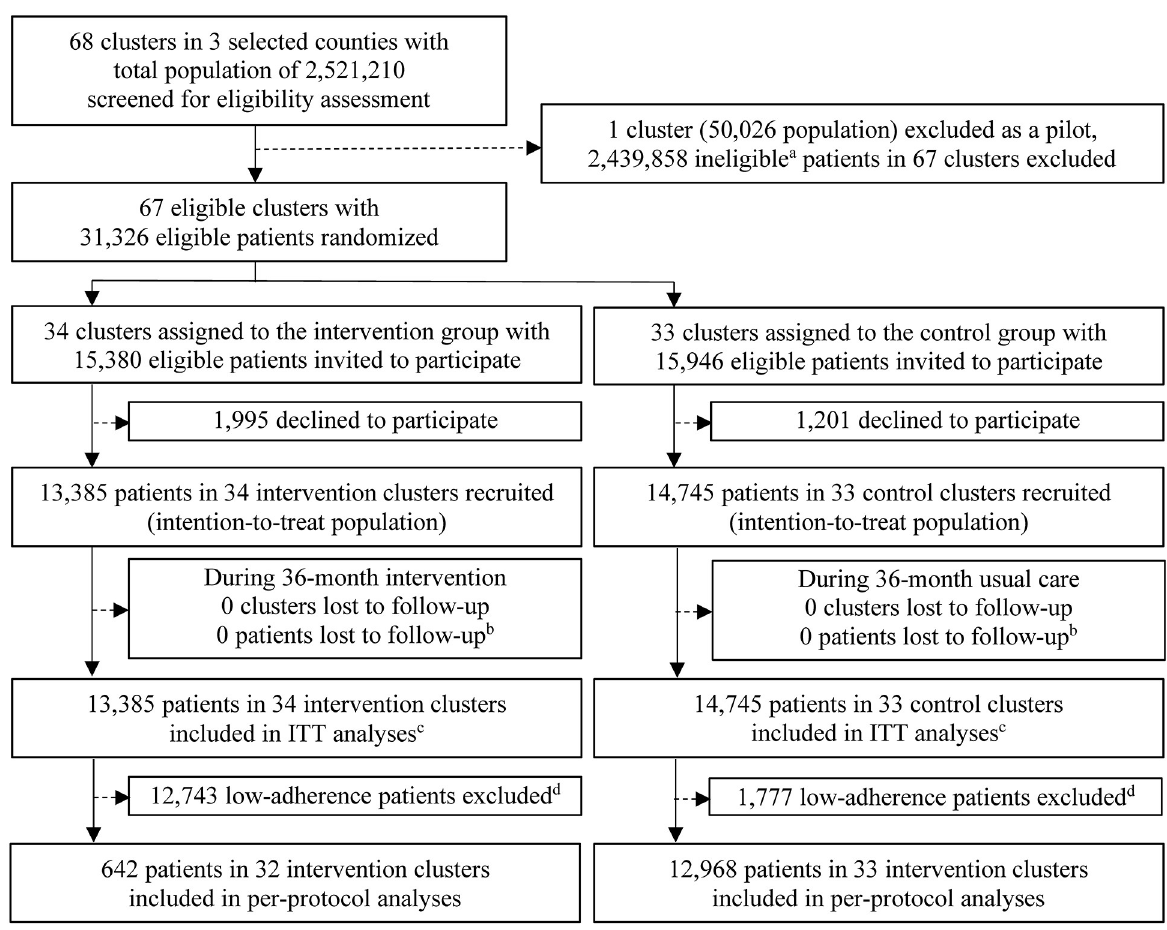
Fig 1. Trial profile. a Ineligible patients included 2,419,058 who didn’t meet the eligibility criteria (aged 50–74 years, with a calculated 10-year CVD risk � 20% and having hypertension, or diagnosed with type 2 diabetes); 222 who had mental diseases; 492 who had cancers; 2,076 who had pre- existing acute coronary heart disease or had experienced a stroke according to heath records; 293 whose diastolic blood pressure was < 60 mm Hg; 16,562 who were out of town for more than 3 months or were non-locals/urban residents; and 1,155 who couldn’t take the recommended medicines due to other severe diseases. b Patients whose records of acute cardiovascular diseases or death could not be obtained at the end of the 36-month follow-up period were categorised as lost to follow-up. c Patients who died (intervention = 366, control = 483), moved out of cluster catchment areas (intervention = 135, control = 194), were subsequently found to have pre-existing acute cardiovascular diseases not identified through initial health records (intervention = 76, control = 83), or subsequently decided to leave the trial within the first quarter of the follow-up period (intervention = 1,144, control = 1,694) are all included in the main (covariate unadjusted) intention-to-treat (ITT) analyses. d Patients excluded from the per-protocol analysis: (1) AU : PleasecheckthattheeditstoFig 1 ; footnoted ; exclusioncriterion 1 arecorrect : Ifnot ; pleaseedit : patients in the intervention group who did not report taking both suggested hypertensive medicines and a statin/ aspirin for more than half of the follow-up period before the occurrence of acute cardiovascular disease, if they had an occurrence, or until the end of follow-up, if they did not ( n = 11,523); (2) patients who were subsequently found to have pre-existing acute cardiovascular diseases not identified through initial health records (intervention = 76, control = 83); and (3) patients who subsequently decide to leave the trial within the first quarter of the follow-up period (intervention = 1,144, control = 1,694).